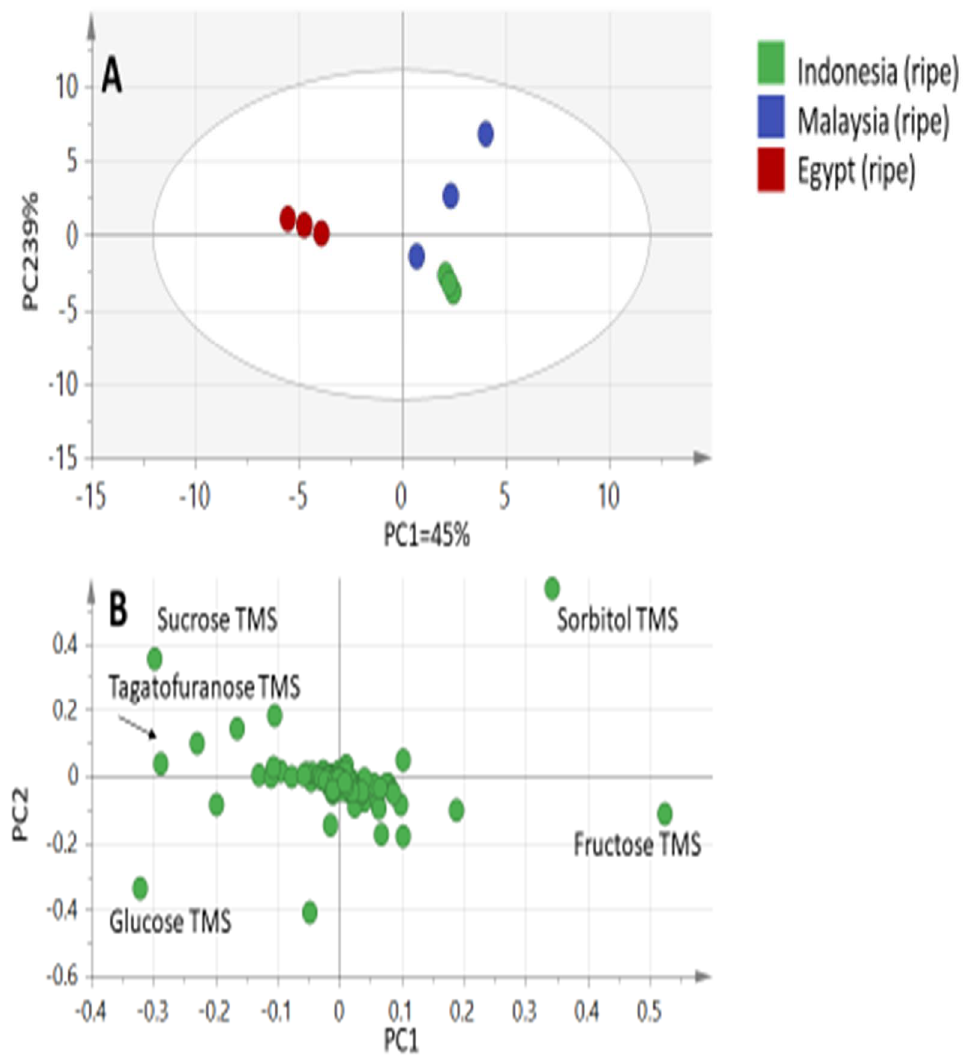
Figure 3. Principal component analyses of silylated ripe fruit extracts as analyzed by GC-MS ( n = 3). ( A ) Score plot of PC1 vs. PC2 scores. ( B ) Loading plot for PC1 and PC2 contributing mass peaks and their assignments.